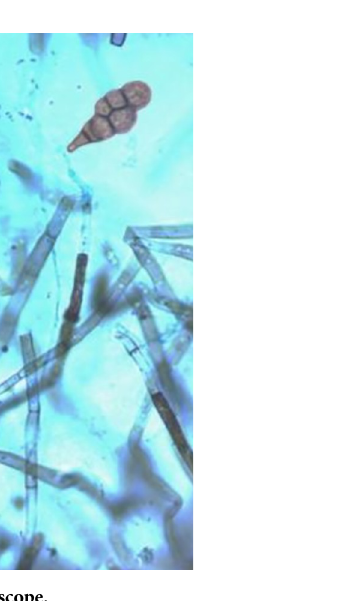
Fig 1. Morphology of endophytic fungus AE1 under light microscope.